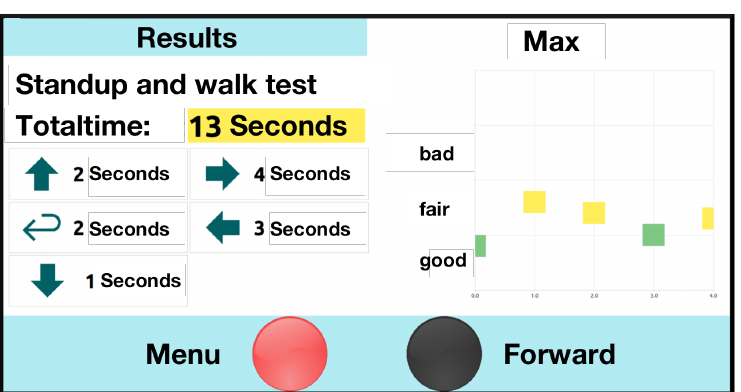
Figure 4. The initial results presentation for the TUG test combines the overall test duration, the du- ration of the relevant iTUG sub-phases, and a color-encoded presentation in a timeline (on the